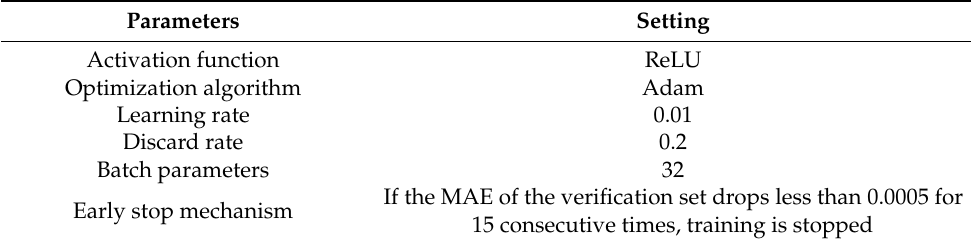
Table 2. Parameter